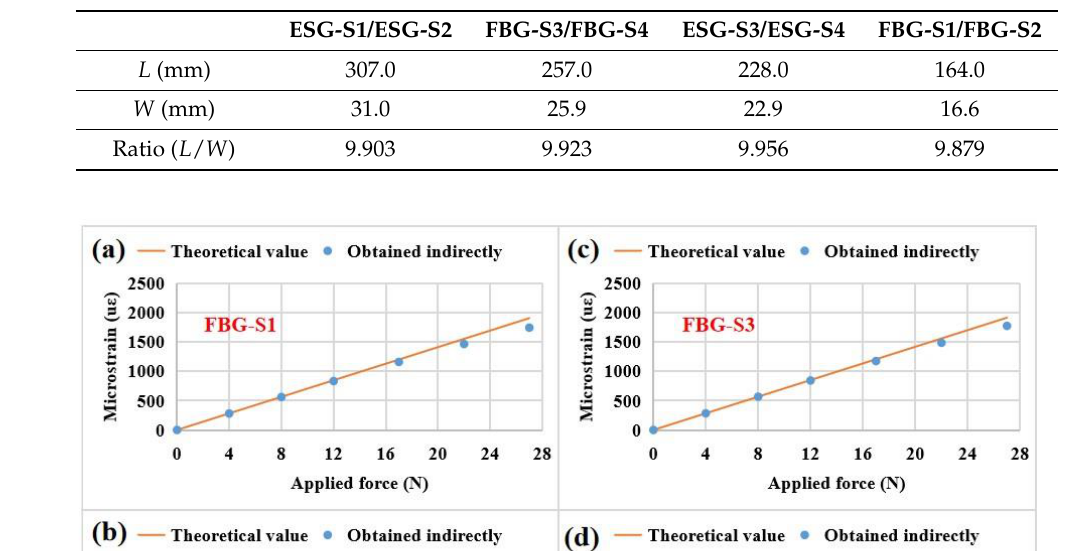
Figure 8. Comparisons of the theoretical and practical microstrains of the four ESG sensors mounted on the cantilever beam as a function of the applied forces from 0 N to 27 N: ( a ) ESG-S1, ( b ) ESG-S2, ( c ) ESG-S3, ( d ) ESG-S4. Table 3. Comparisons of the installation information for four ESG sensors and four FBG strain sensors that were mounted on the cantilever beam.